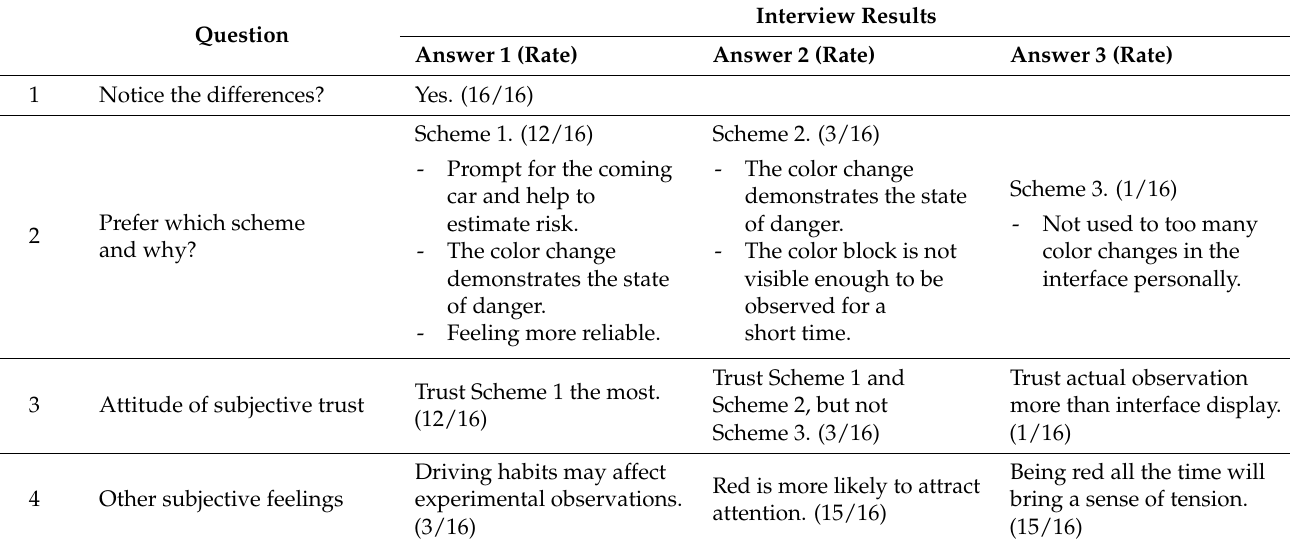
Table 6. The results of